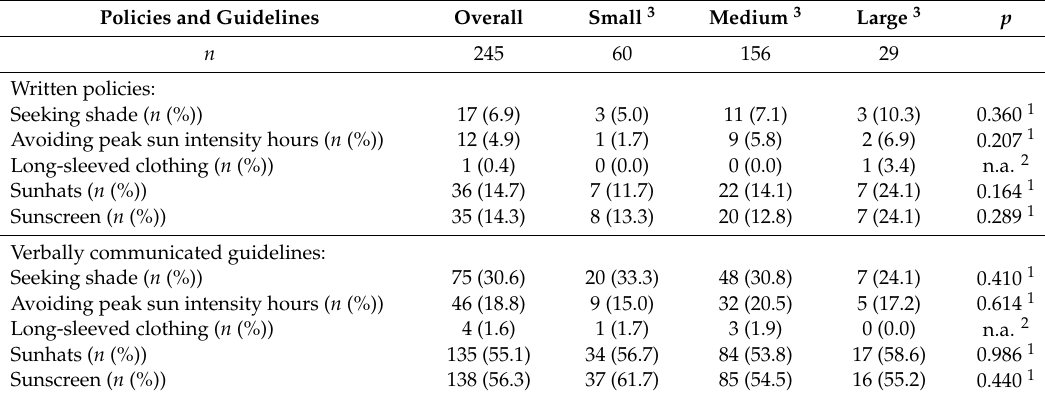
Table 3. Written policies and verbally communicated guidelines regarding sun protection existent in 245 nurseries in Bavaria, southern